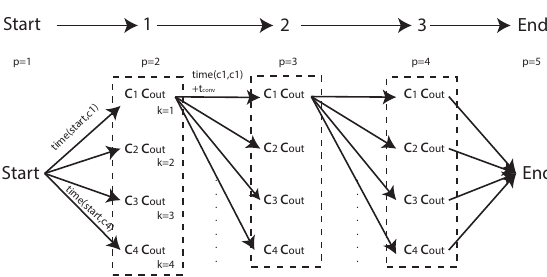
Figure 17. Above: the cell connectivity graph formed from cell adjacency only; Below: cell connectivity graph is expanded to give the full traversal graph including all corner combinations.